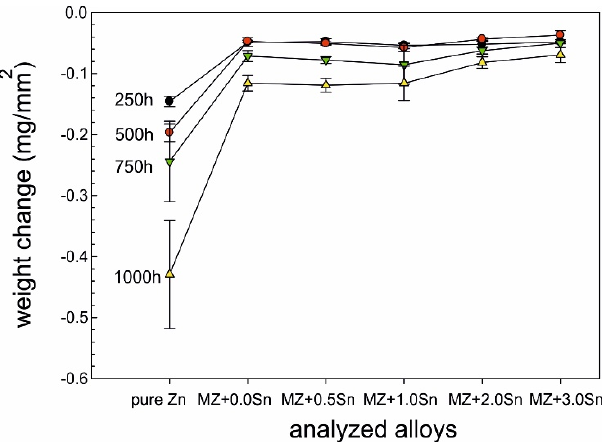
Figure 2. Weight change after corrosion measured on annealed samples.